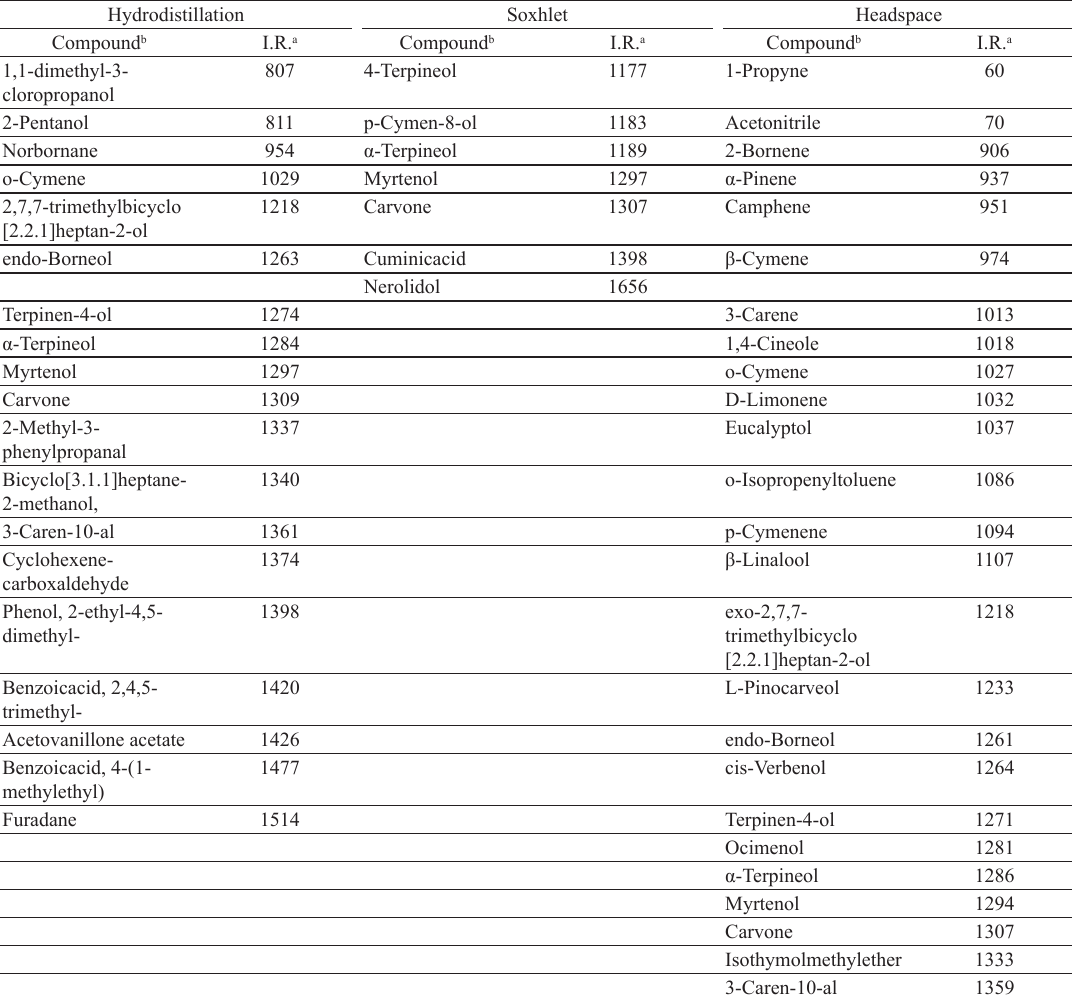
Table 12. Compounds detected in Thuja plicata essential oils extracted by hydrodistillation, soxhlet and headspace. Hydrodistillation Soxhlet